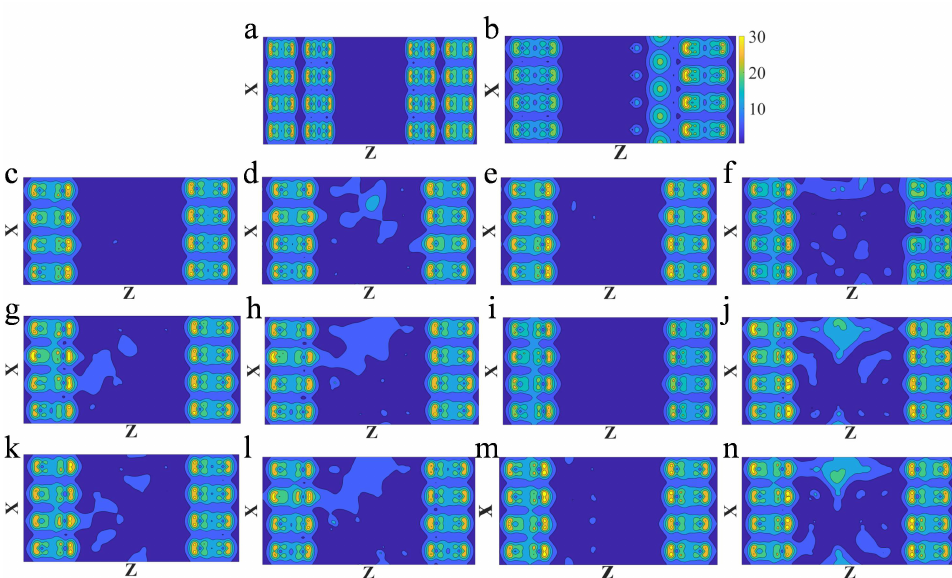
Figure 3. Comparison of local density of states near Fermi level between the defect-free model and different defect models. ( a ) the local density of states in model 3 without any defects; ( b ) the local density of states in model 3b; ( c , g , k ) the local density of states in the model 3c, 3c-com1, and 3c-com2, respectively; ( d , h , l ) the local density of states in the model 3d, 3d-com1, and 3d-com2, respectively; ( e , i , m ) the local density of states in the model 3e, 3e-com1, and 3e-com2, respectively; ( f , j , n ) the local density of states in the model 3f, 3f-com1, and 3f-com2, respectively.